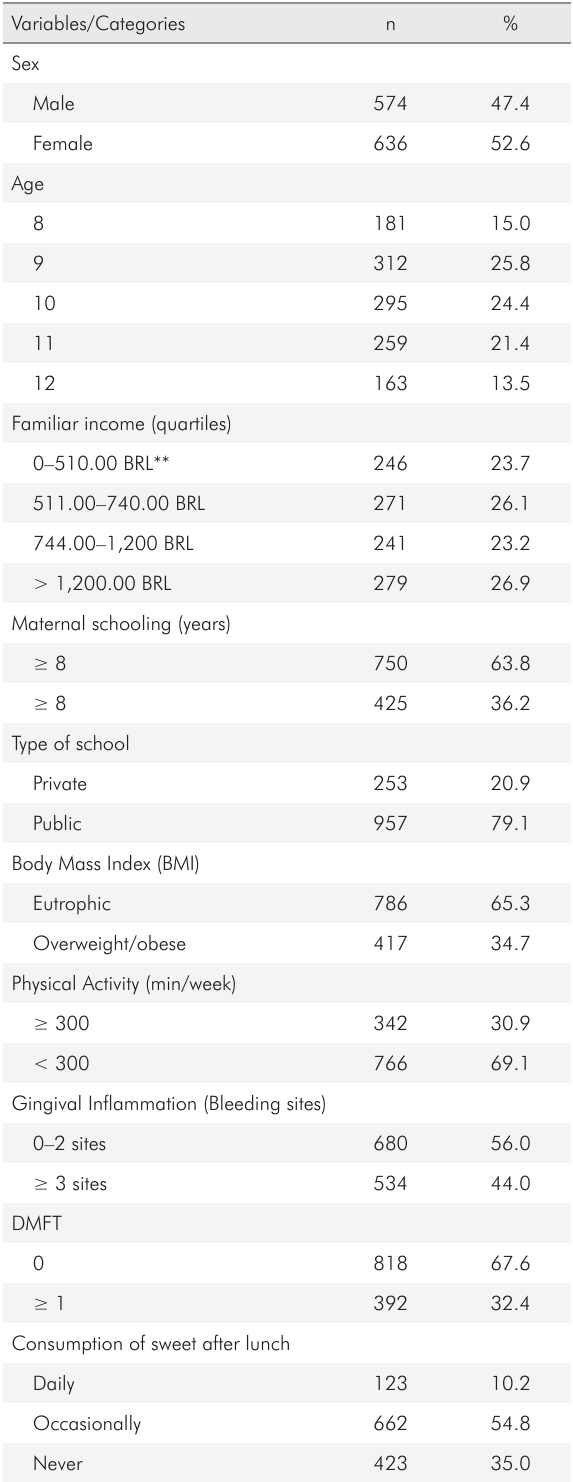
Table 1. Distribution of participants by socioeconomic, familiar and biological characteristics. Absolute (n) and relative (%) frequencies. Pelotas, Brazil. (n =